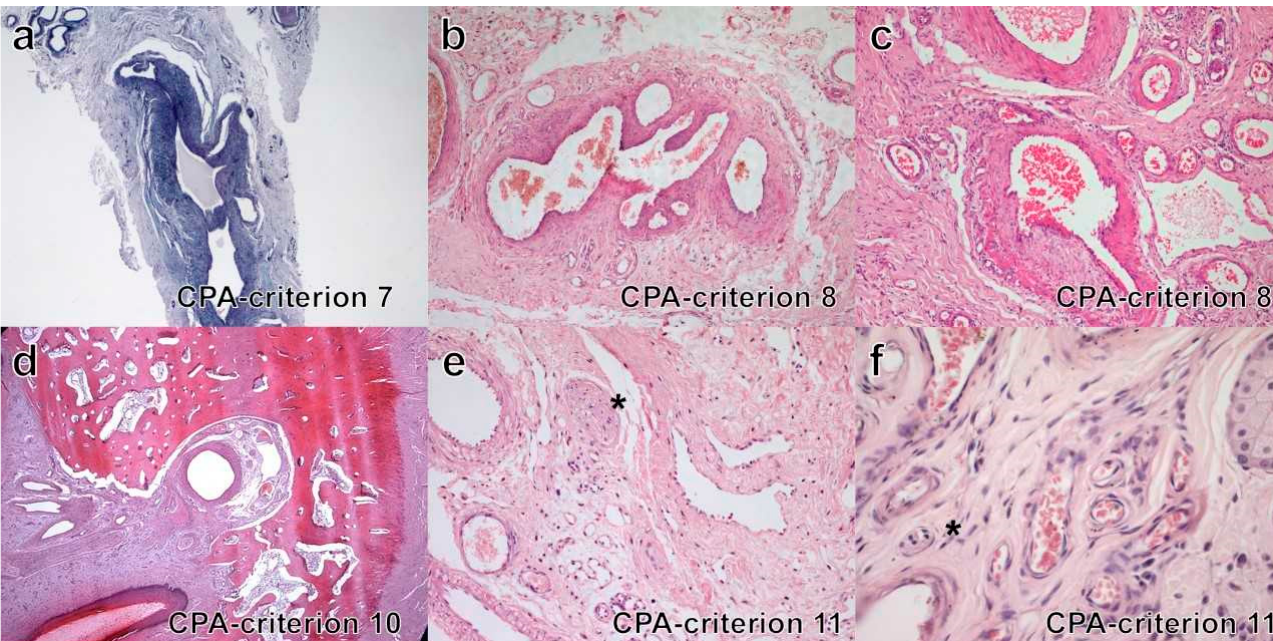
Figure 4. Histopathology in cases of CPA and HS (H&E stain): criteria 7, 8, 10 and 11. ( a ) CRITERION 7, CPA, case n. 6: arteriovenous shunt; ( b ) CRITERION 8, CPA, case n. 5: malformed vessel; ( c ) CRITERION 8, CPA, case n. 23: malformed vessel; ( d ) CRITERION 10, CPA, case n. 28: bone invasion; ( e ) CRITERION 11, CPA, case n. 14: intralesional nerve bundle (asterisk); ( f ) CRITERION 11, CPA, case n. 15: intralesional nerve bundle (asterisk).